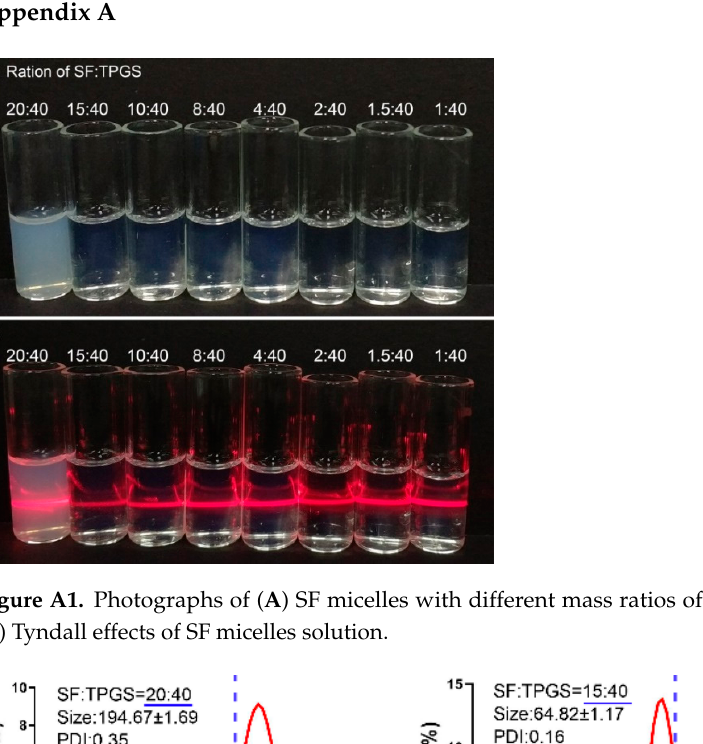
Figure A2. Size distribution of SF micelles with different mass ratios of SF:TPGS measured by DLS.